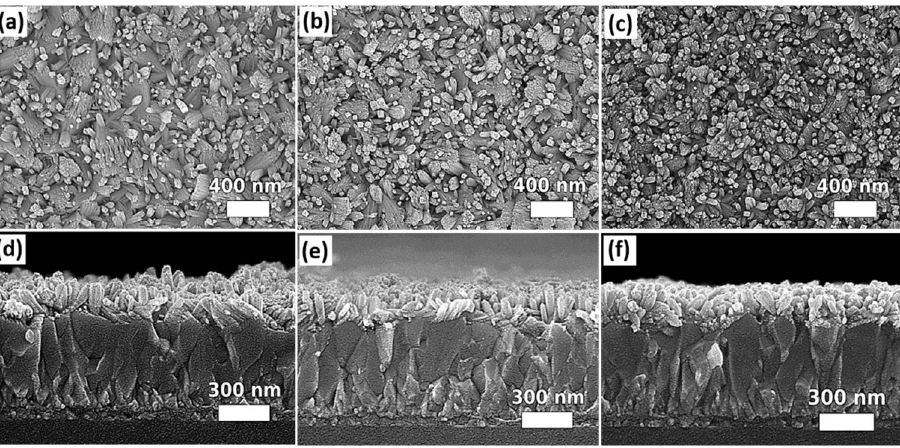
Figure 3. SEM top and cross-sectional images of samples mounted in various orientations for sol- volthermal growth: ( a , d ) 45°, ( b , e ) 90°, and ( c , f ) 0°. solvolthermal growth: ( a , d ) 45 ◦ , ( b , e ) 90 ◦ , and ( c , f ) 0 ◦